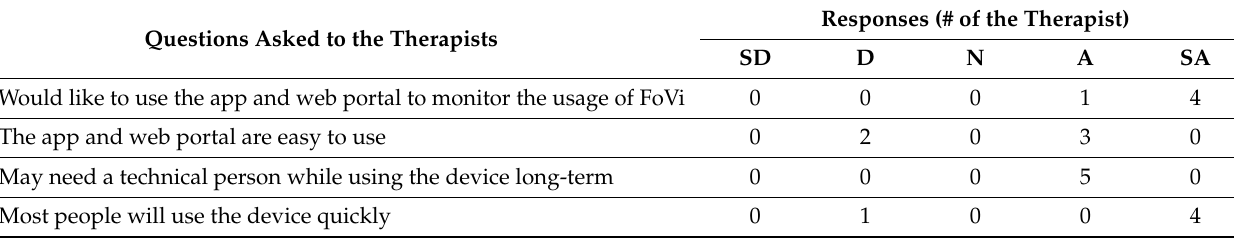
Table 2. Therapists’ feedback on the FoVi prototype, app, and web portal (SD = Strongly disagree, D = disagree, N = neither agree nor disagree, A = agree, and SA = Strongly